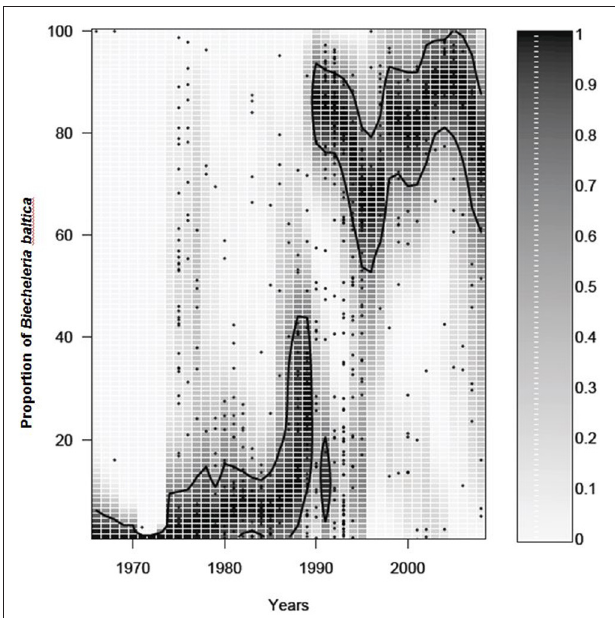
FIGURE 3 | Temporal change in the proportion of Biecheleria baltica from the total dinoflagellate biomass. All other notions as in Figure 2